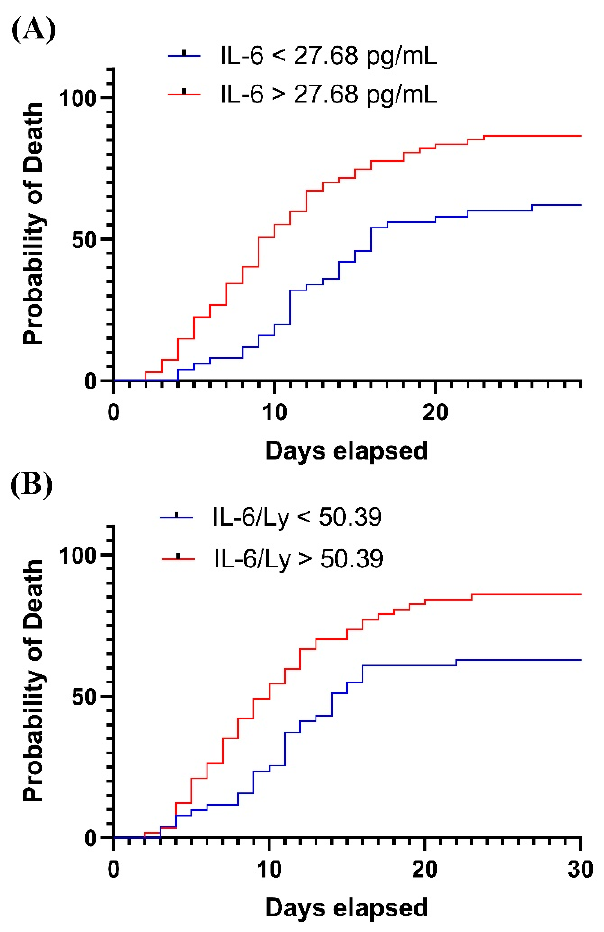
Figure 2. Kaplan-Meier curves for ( A ) IL-6; ( B ) IL-6/Ly. Significantly lower survival rates were observed for patients with increased urea (>55.85 mg/dL, p < 0.0001), AST (>44.15 U/L, p = 0.0209), INR (>1.075, p = 0.0091). In addi- tion, decreased pH (<7.455, p = 0.0029) is associated with a lower survival rate for critical patients (Figure 3).